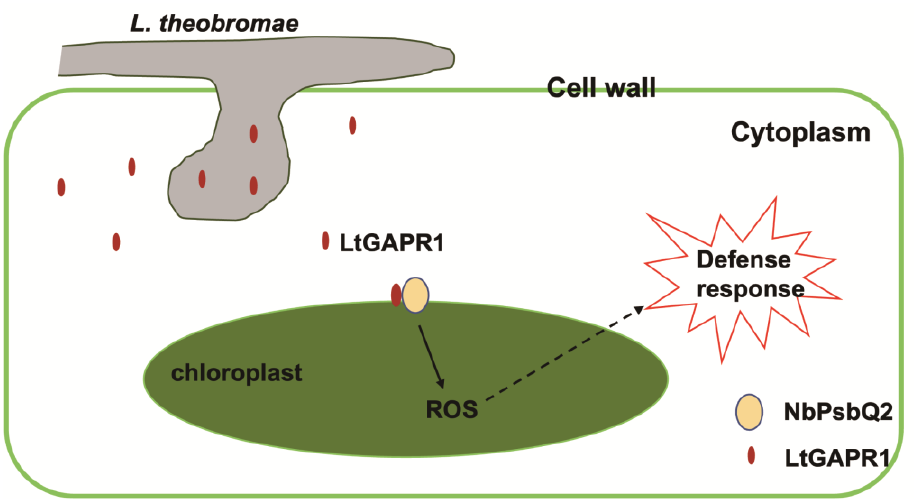
Figure 6. A working model illustrating how LtGAPR1 interacts with NbPsbQ2 for active ROS production to further enhance plant defense.